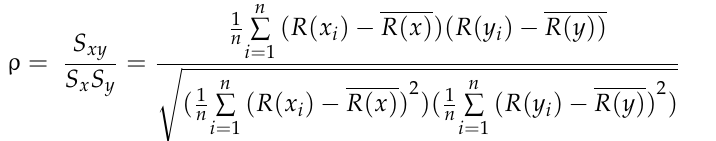
Surface Ground Spreading Oil Density Thickness Coefficient 1 0 0 0